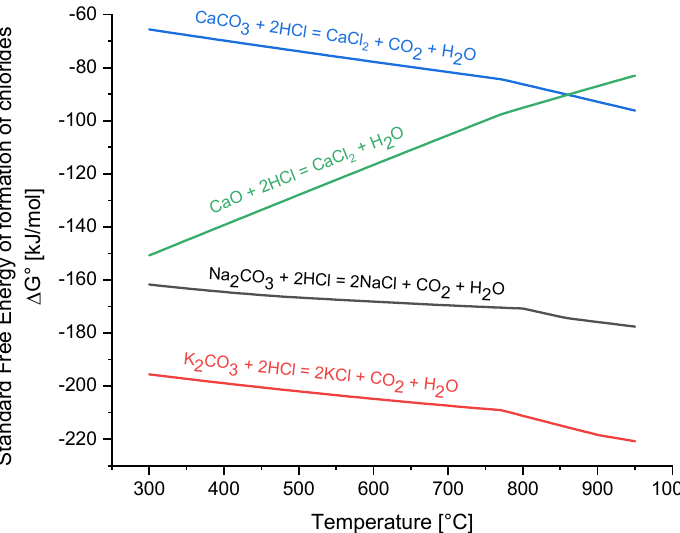
Figure 2. Standard free energy of the formation of alkali and alkaline earth chlorides.